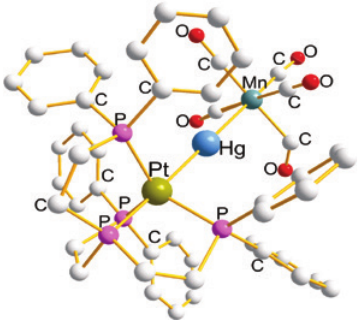
Figure 4: The structure of [( η 4 -pp3)PtHgMn(CO)